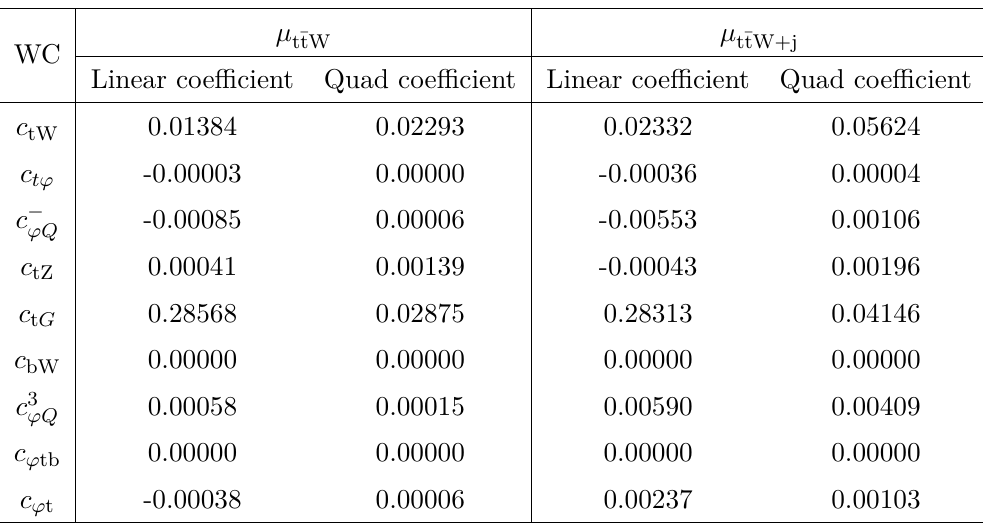
Table 6 . Summary of quadratic fit coefficients for the t¯tW parameterization for µ t¯tW and µ t¯tW+j . As discussed in the text, the cross sections are normalized to the SM.